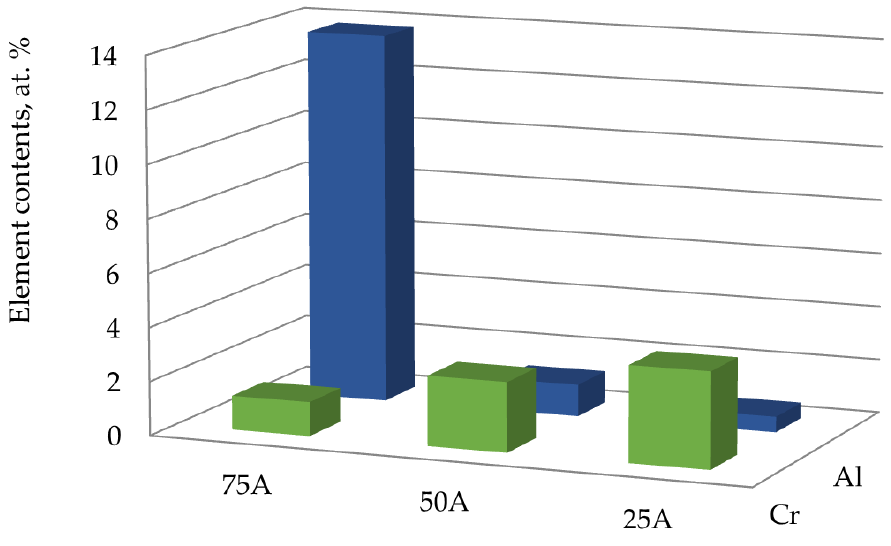
Figure 5. Contents of Al and Cr in the witness substrate coatings: 75A, 50A, and 25A.